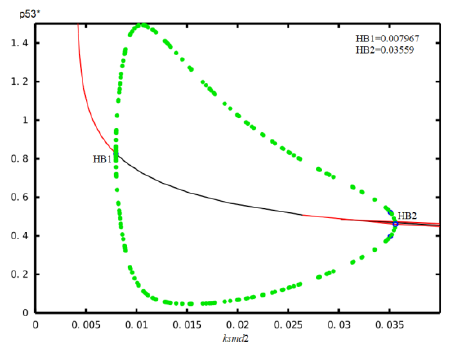
Figure 8. The bifurcation diagram of p53* concentration corresponds to the parameter k smd2 .